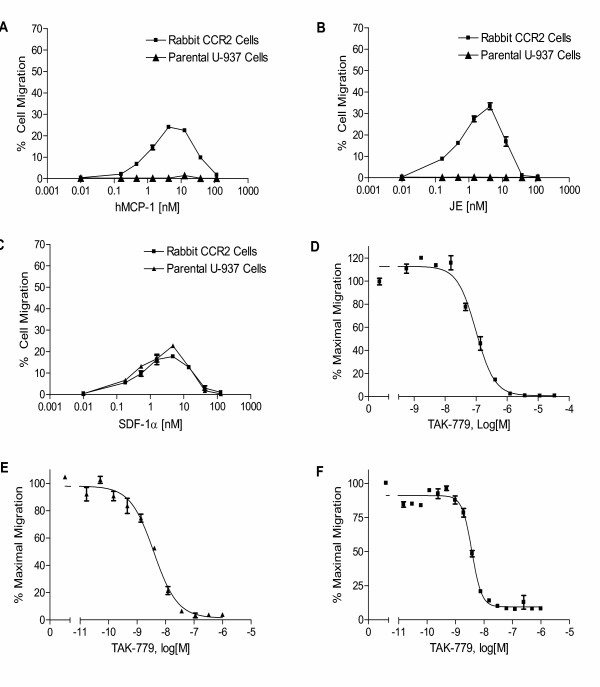
Chemotaxis assay in U-937/rabbit CCR2 stable transfectants. Chemotaxis assays were performed in parental U-937 or U-937/rabbit CCR2 stable transfectants using increasing concentrations of human MCP-1 (A), mouse JE (B) or human SDF-1α (C). The effect of TAK-779 on rabbit CCR2-induced chemotaxis was tested in the presence of 4 nM of mouse JE (D) or hMCP-1 (E). Effect of TAK-779 on hCCR2-induced chemotaxis in the presence of 4 nM of hMCP-1 (F). Each point represents means of the triplicate from one assay.